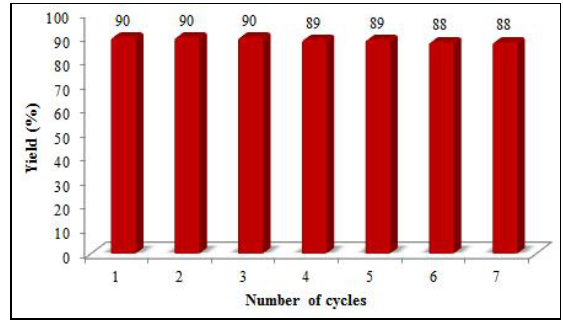
Fig. 5. Recycled nano TiO catalyzed condensation 2 between dimedone (1mmol), benzaldehyde (1 mmol) and ammonium acetate (1 mmol) within 90